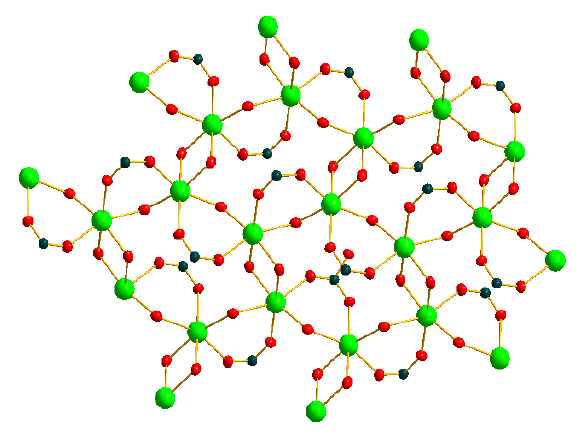
Figure 1: The coordination environment of Na(I) in 1 .